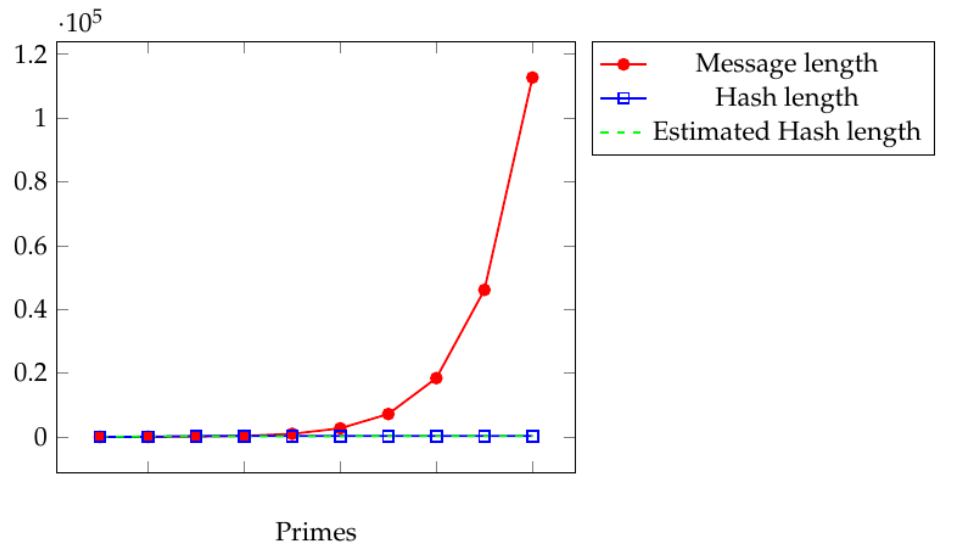
Figure 10. The specialized Brauer message given by a product of ( i + 1 ) 2 i . Sosnovski matrices are compressed by f ( i ) = 225.7621855345912 + 0.04323899371069182